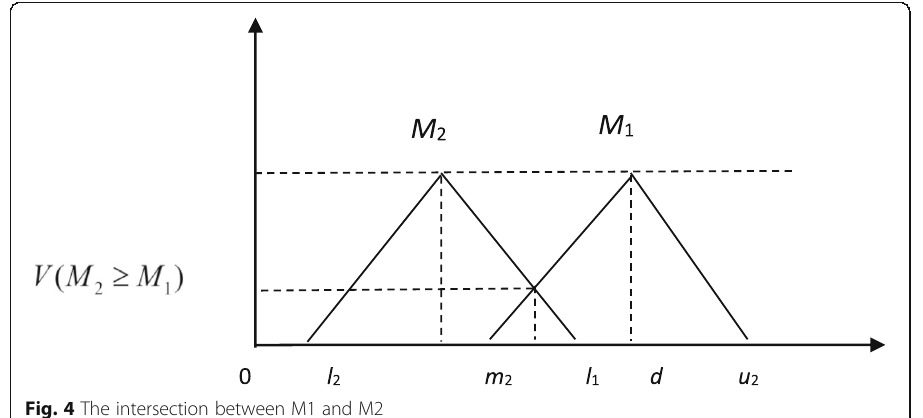
Fig. 4 The intersection between M1 and M2